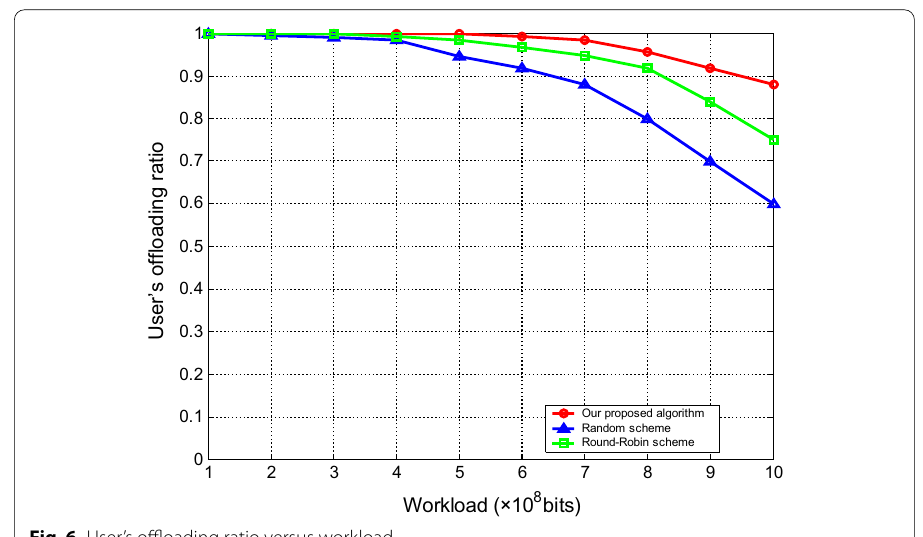
Fig. 6 User’s offloading ratio versus